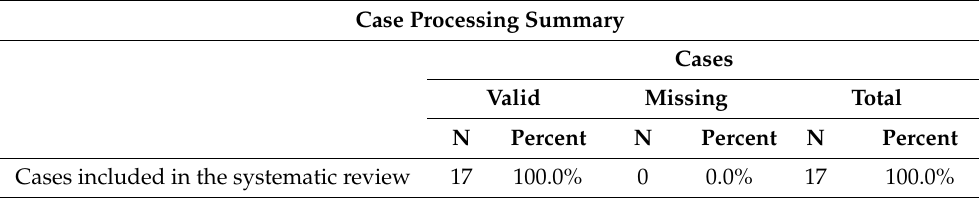
Figure 5. Risk ratio of systematic reviews which assessed the feasibility vs. non-feasibility rates of their respective trends represented on a forest plot after meta-analysis [20,26,27]. Table 3. Case processing summary of selected studies for interrater